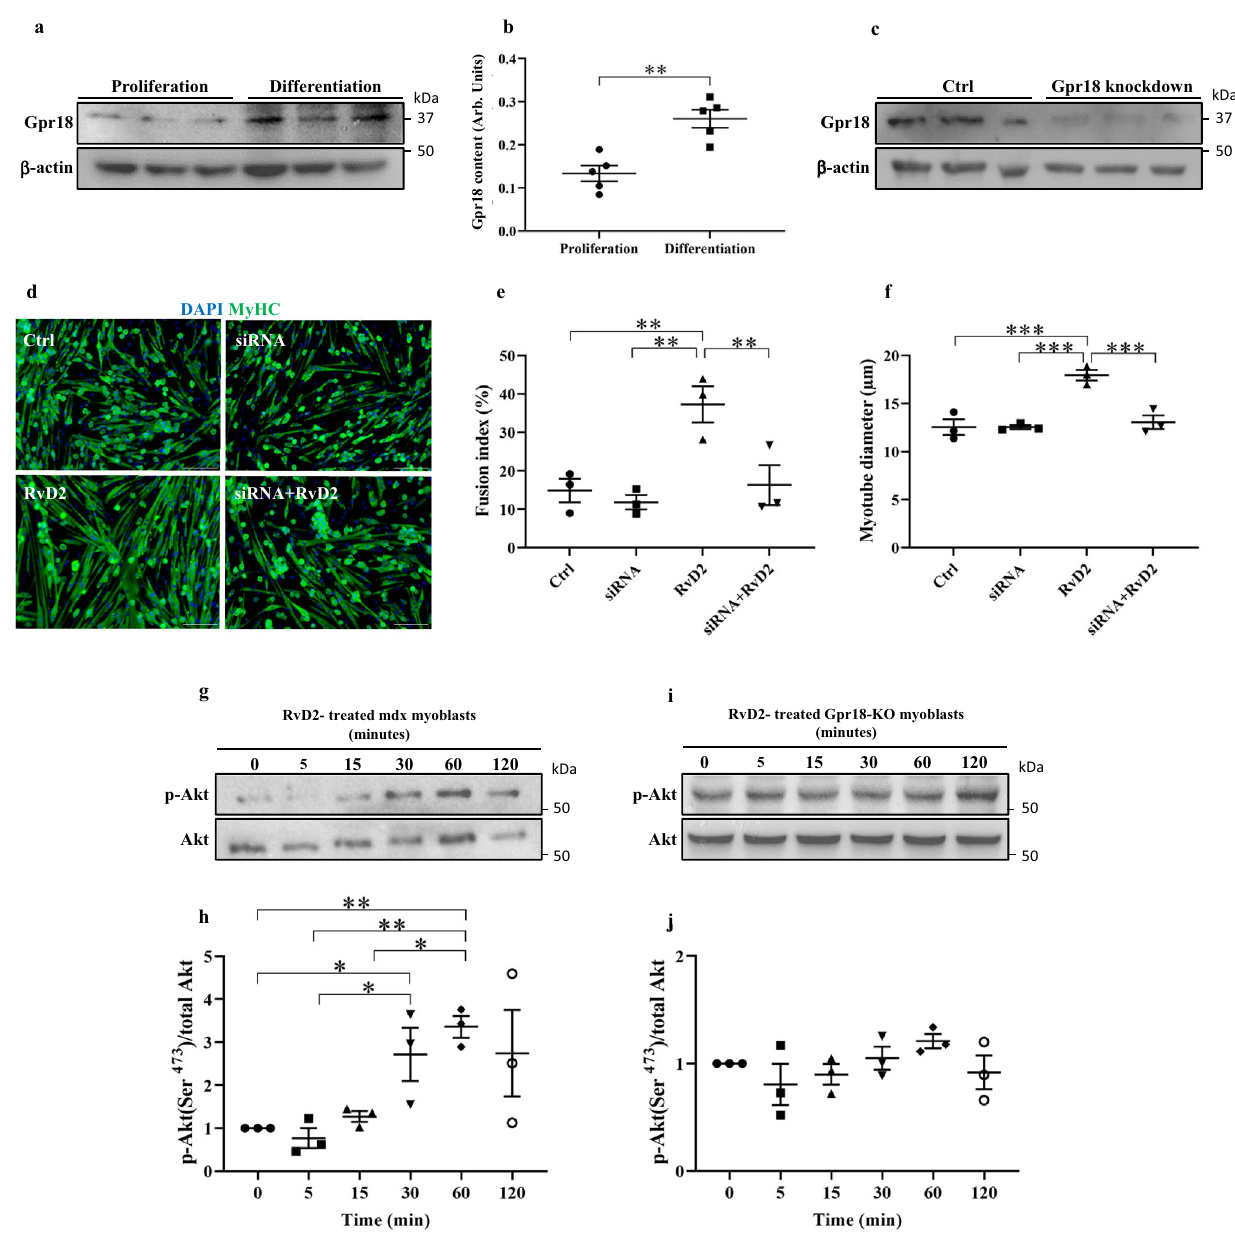
Fig. 3 The effect of Resolvin-D2 on the myogenesis capacity of myogenic cells is mediated by Gpr18. a Representative Western blot and b quanti fi cation of Gpr18 expression in proliferating myoblasts and differentiated myoblasts (1 day in differentiating medium) isolated from mdx mice (data are presented as mean ± SEM, n = 5 biologically independent samples, two-tailed unpaired Student ’ s t -test; p = 0.0018). c siRNA knockdown of Gpr18 on primary myoblasts isolated from mdx mice. d – f Dystrophin-de fi cient myoblasts were treated with siRNA-scrambled (Ctrl) or siRNA-Gpr18 (siRNA) and cultured in differentiating media containing Resolvin-D2 (RvD2, 200 nM) or not for 4 days. d Representative images of myotubes stained for MyHC. Scale bars = 75 μ m. Quanti fi cation of ( e ) the fusion index (siRNA vs. Ctrl, p = 0.5967; RvD2 vs. Ctrl, p = 0.0038; siRNA + RvD2 vs. Ctrl, p = 0.8042; RvD2 vs. siRNA, p = 0.0018; siRNA + RvD2 vs. siRNA, p = 0.4428; siRNA + RvD2 vs. RvD2, p = 0.0055), and f the myotube diameter (siRNA vs. Ctrl, p = 0.9937; RvD2 vs. Ctrl, p = 0.0003; siRNA + RvD2 vs. Ctrl, p = 0.5762; RvD2 vs. siRNA, p = 0.0003; siRNA + RvD2 vs. siRNA, p = 0.5710; siRNA + RvD2 vs. RvD2, p = 0.0005). g – j Representative Western blot and quanti fi cation of the p-Akt (phosphorylation on Ser473)/total Akt-1 ratio in primary myoblasts isolated from g , h mdx mice (0 vs. 30 min, p = 0.0329; 0 vs. 60 min, p = 0.0062; 5 vs. 30 min, p = 0.0181; 5 vs. 60 min, p = 0.0034; 15 vs. 60 min, p = 0.0128) or i , j Gpr18-knockout mice cultured for 0, 5, 15, 30, 60, or 120 min with RvD2. For Western blot experiments, the samples derive from the same experiment and the gels/blots were processed in parallel. Data are presented as mean ± SEM, n = 3 biologically independent samples performed in technical duplicates and analyzed with one-way ANOVA uncorrected Fisher ’ s LSD test ( e , f , h , and j ). All data were analyzed with a 95% con fi dence interval. * p < 0.05, ** p < 0.01, *** p <